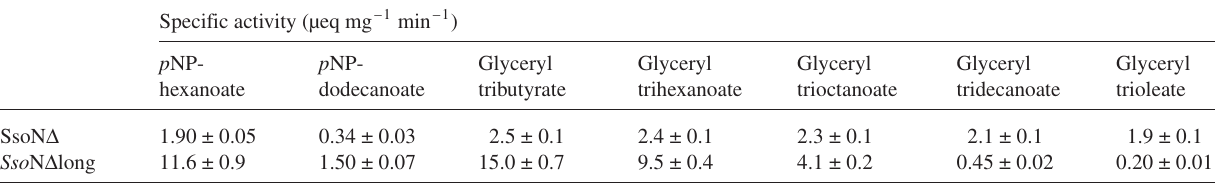
Table 2. Esterase activity toward p NP-esters and triacyglycerols was measured at 50 °C by pH titration with a radiometer apparatus. Each assay was done in duplicate or triplicate with the standard assay. Results are the means of two independent experiments. Specific activity (µeq mg –1 min –1